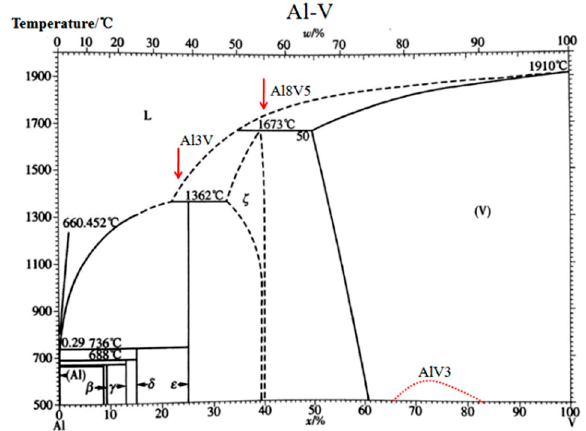
Figure 2. Phase diagram of the Al ‐ V system.